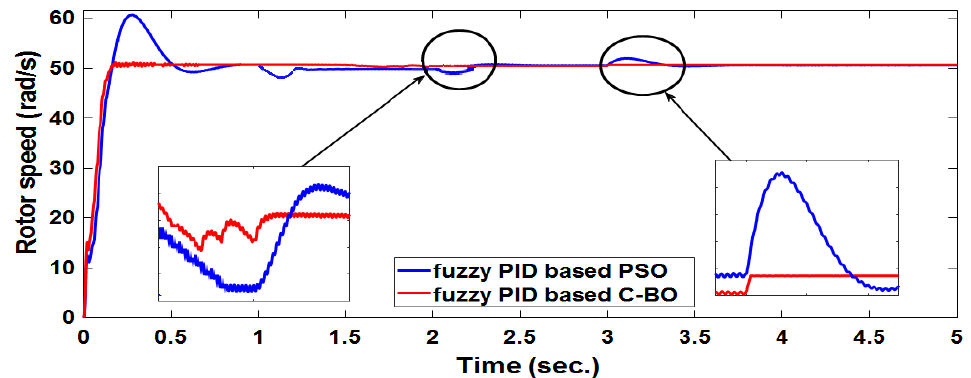
Figure 20. The motor speed for the desired speed, 50 rad/s.